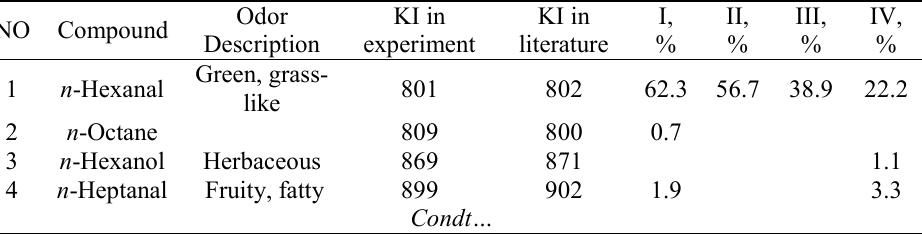
Table 2. Flavor volatiles identified in headspace of HD5 rice